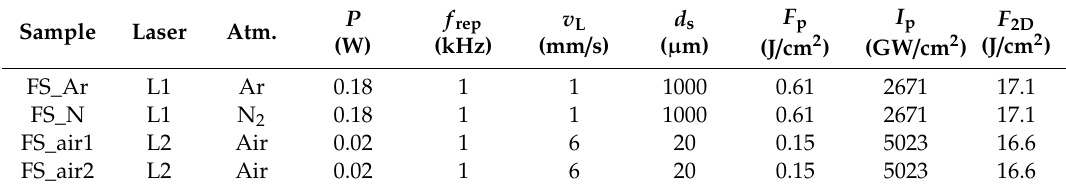
Table 1. Laser processing parameters used in 25 µ m thick Nb foil samples irradiated with fs-lasers. Sample